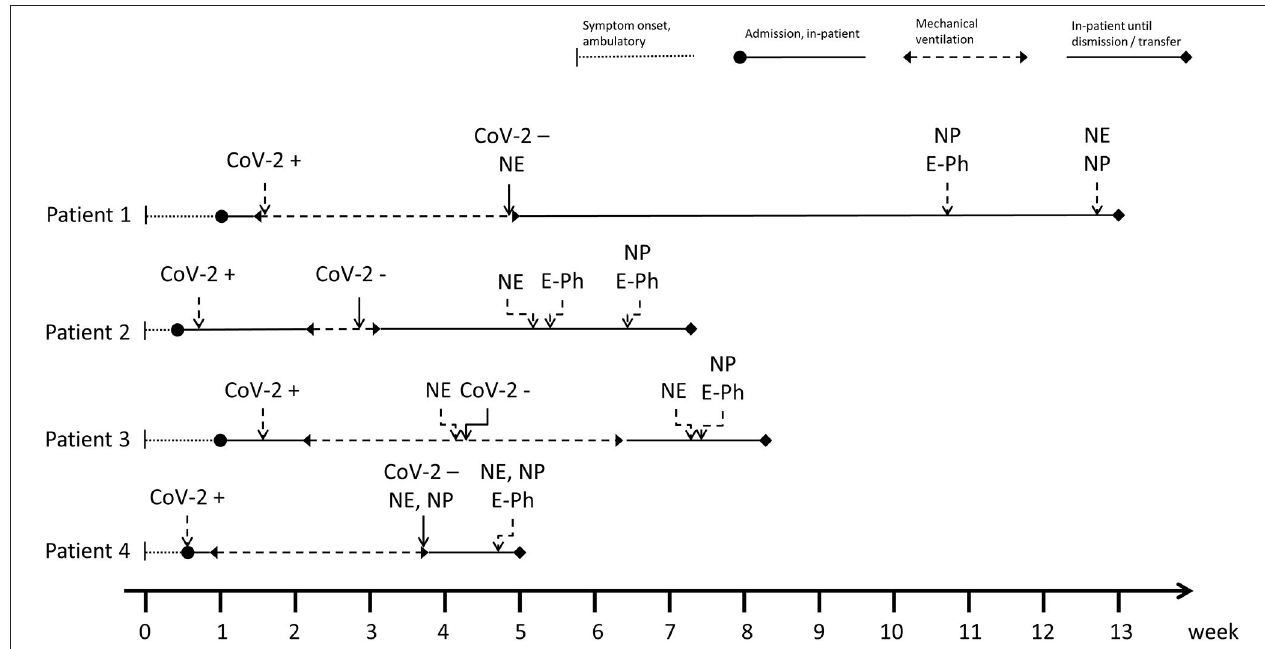
FIGURE 1 | Detailed time course and series of events of all four patients, including the duration of mechanical ventilation, and time of neurological, neurophysiological, and neuropsychological investigations. CoV-2 + /–, CoV-2 PCR first time positive/negative; NE, neurological examination; NP, neuropsychological examination; E-Ph, electrphysiological